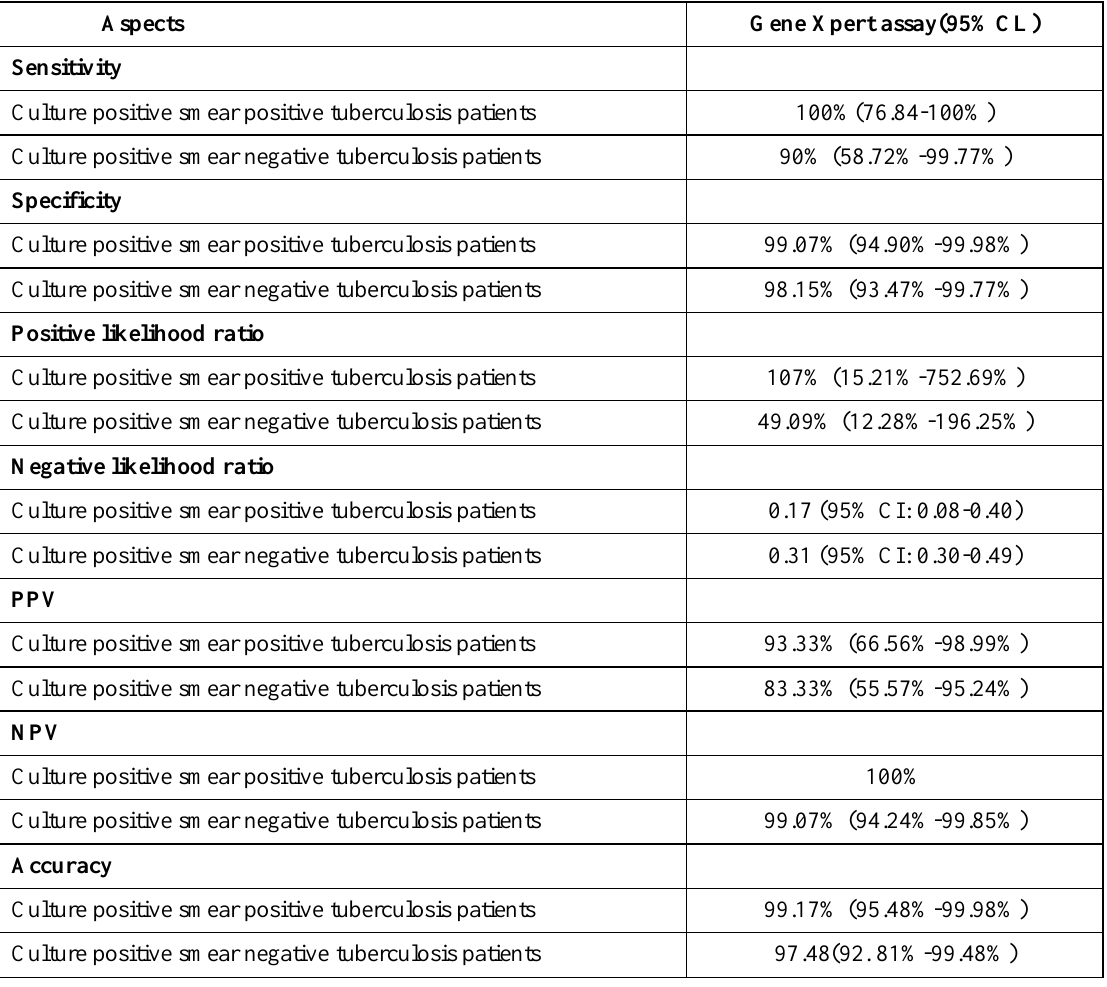
Table 4. Gene Xpert MTB/RIF assay performance in detection of MTB